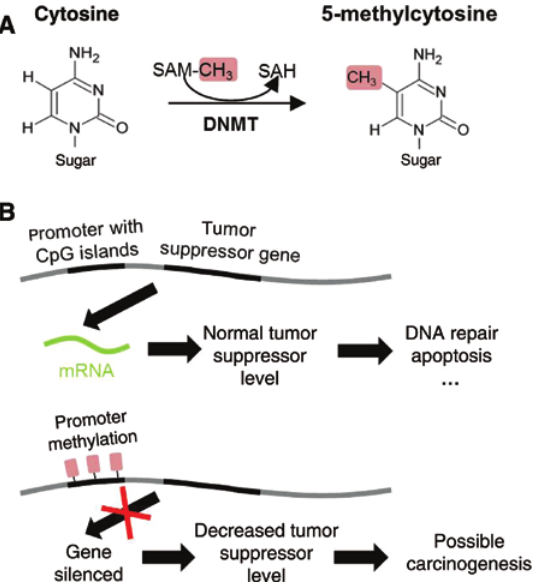
Figure 1: (A) Methylcytosine is formed by an addition of the methyl group (donated from S-adenosyl methionine, SAM) to a 5-carbon of the cytosine, catalyzed by DNA methyltransferase (DNMT) enzymes. (B) Simplified overview of DNA methylation role in the development of cancer. Methylation of CpG islands within a tumor suppressor promoter silences this gene, which results in fewer proteins being synthesized and attenuation of the cell’s